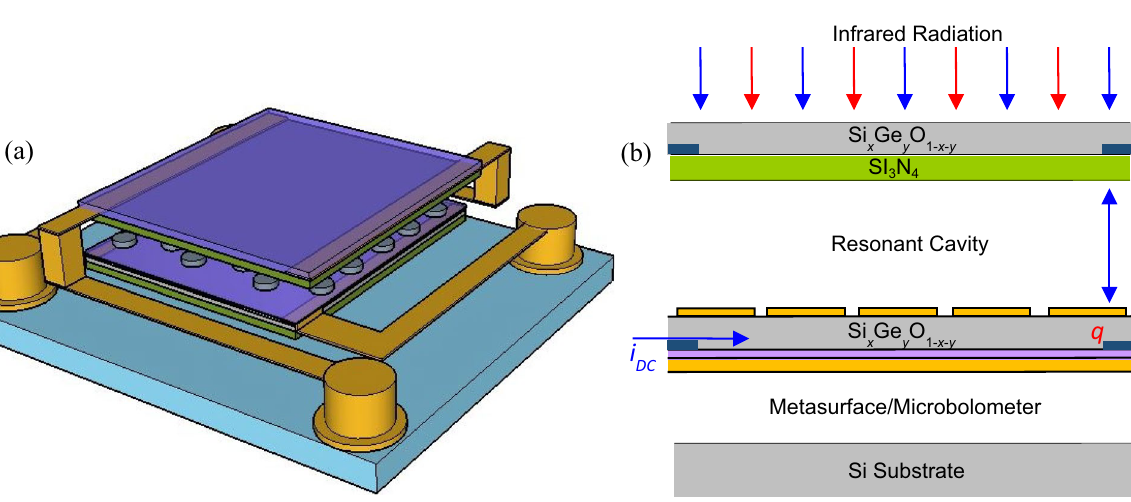
Figure 1. ( a ) 3-Dimensional of the two-microbolometer stack with a pixel area of 40 × 40 µm 2 ( b ) schematic illustration showing the principal operation of the two-band microbolometer the metasurface